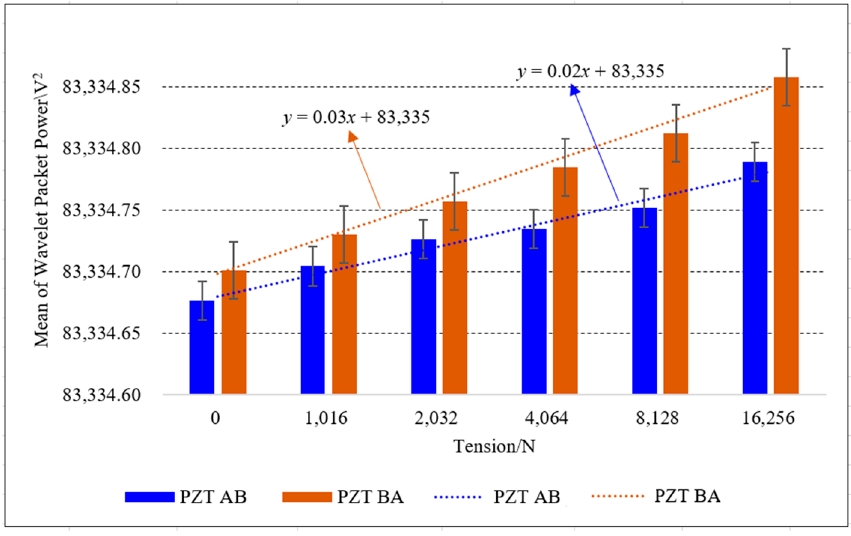
Figure 19. Mean of the wavelet packet energy of two PZT AB combinations.